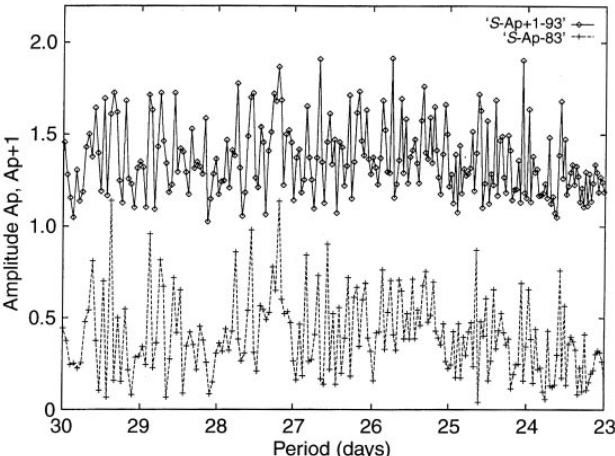
Fig. 2. Fourier spectral amplitudes for the period interval 30–23 days of the Ap time-series 1933–1993 ( S -Ap+1–93) and 1933–1983 ( S -Ap- 83), showing maximal peaks for di(cid:128)erent periodicities, depending on the length of the time-series. In the upper curve one Ap unit was added to the Fourier amplitudes S -Apr+1–93 to separate the